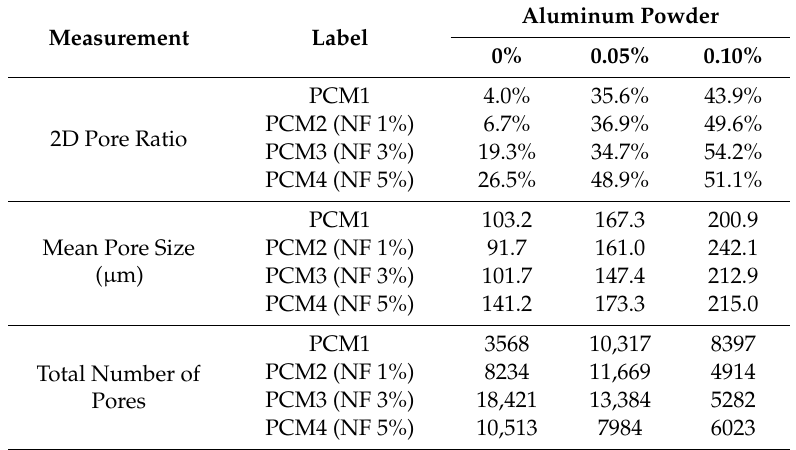
Table 2. Microscopic image processing-based pore analysis using the local method.